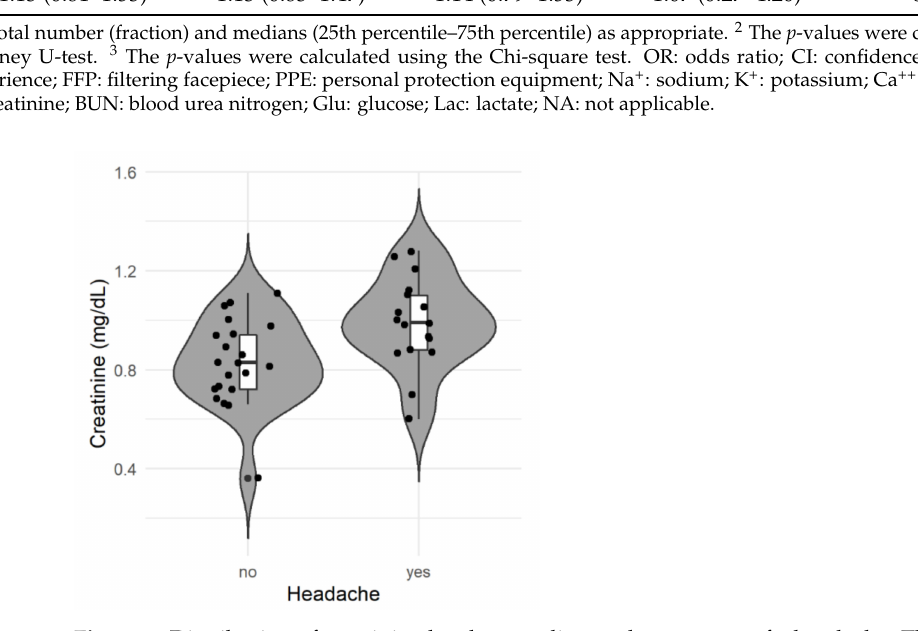
Figure 3. Distribution of creatinine levels according to the presence of a headache. The plot shows the distribution (gray shaded area), boxplot, and value of each patient’s (dots) creatinine levels from both groups (absence or presence of